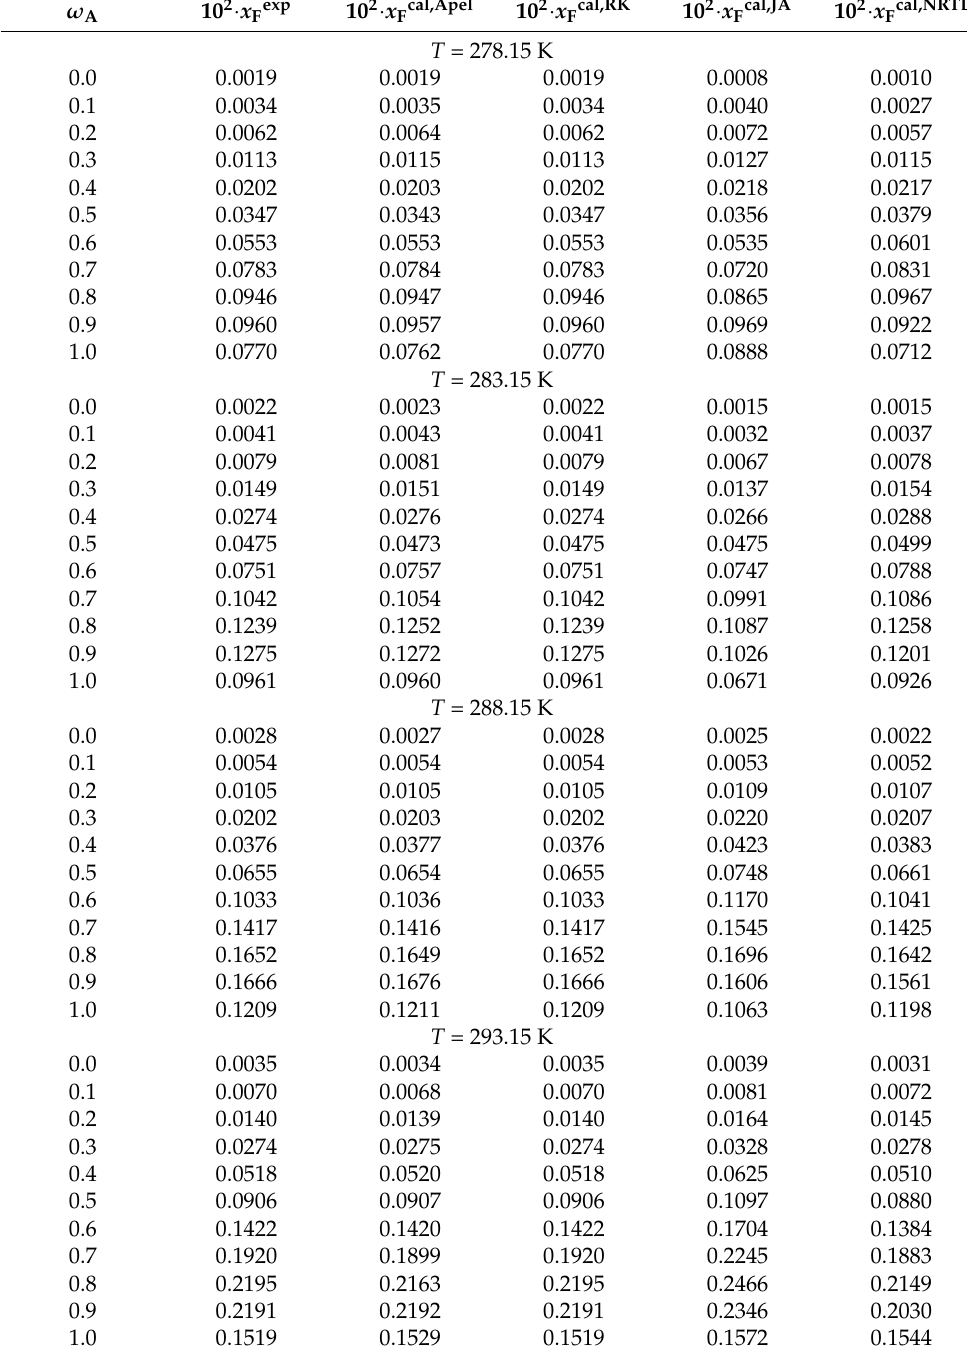
Table 3. Experimental and calculated molar ratio solubility of florfenicol in binary solvent mixtures of 1-propanol + water from T = 278.15 to 318.15